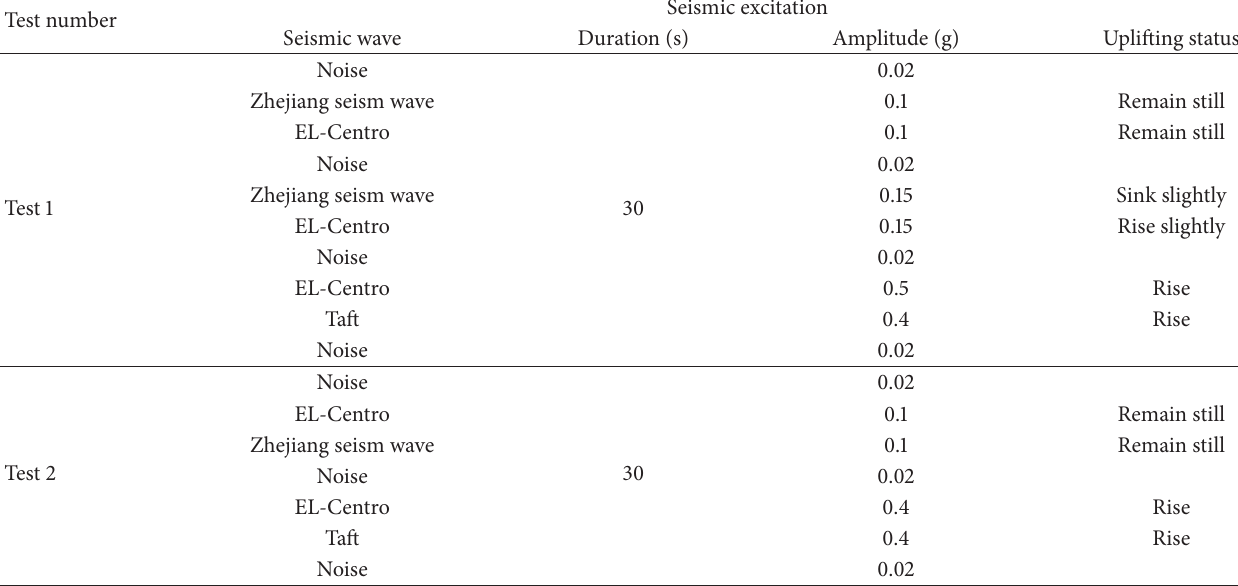
Table 1: Centrifuge testing program and uplifting status of pipe 1# during